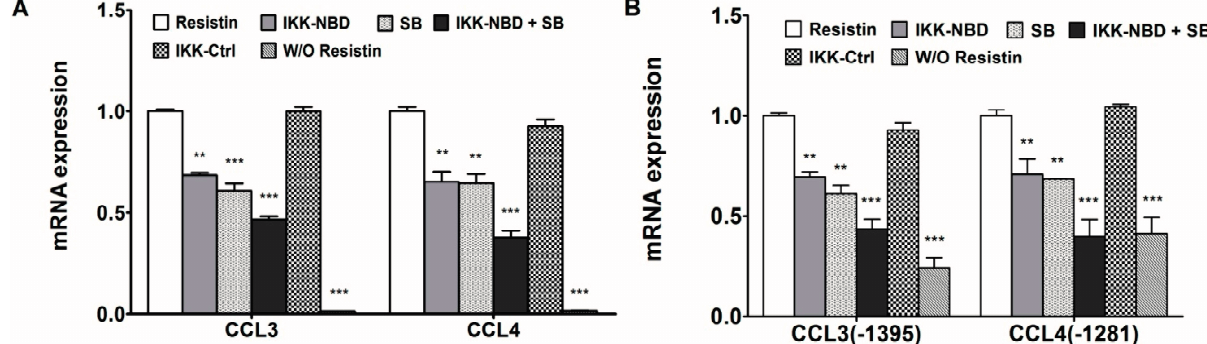
Figure 4. IKK-NBD and SB303580 ( SB ) co-enhance the inhibition of chemokines by human chondrocytes with resistin treatment. ( A ) Human articular chondrocytes (HAC) were pretreated with vehicle ( DMSO ), IKK-NBD peptide (100 μ M), SB303580 (100 μ M), or IKK-NBD control peptide (100 μ M) for 1 h and then exposed to resistin (100 ng/mL) for 4 h. After resistin treatment, total RNA was isolated, and real-time quantitative-PCR was performed; ( B ) The CCL3 ( − 1395) and CCL4 ( − 1281) promoter constructs were transfected into T/C-28a2 cells and incubated for 24 h, then were pretreated with vehicle ( DMSO ), IKK-NBD peptide (100 μ M), SB303580 (100 μ M), and IKK-NBD control peptide (100 μ M) for 1 h and then exposed to resistin (100 ng/mL) for 4 h. Relative luciferase activity indicates the fold expression relative to the activity of the construct co-transfected with empty vector (set as 1) in the presence of resistin (100 ng/mL). W/O resistin means blank control without resistin . The p value of IKK-NBD (100 μ M) or SB303580 (100 μ M) was compared with resistin alone based on student’s t -test ( ** p < 0.01; *** p < 0.001). Each bar represents the mean ± S.D. of at least three independent